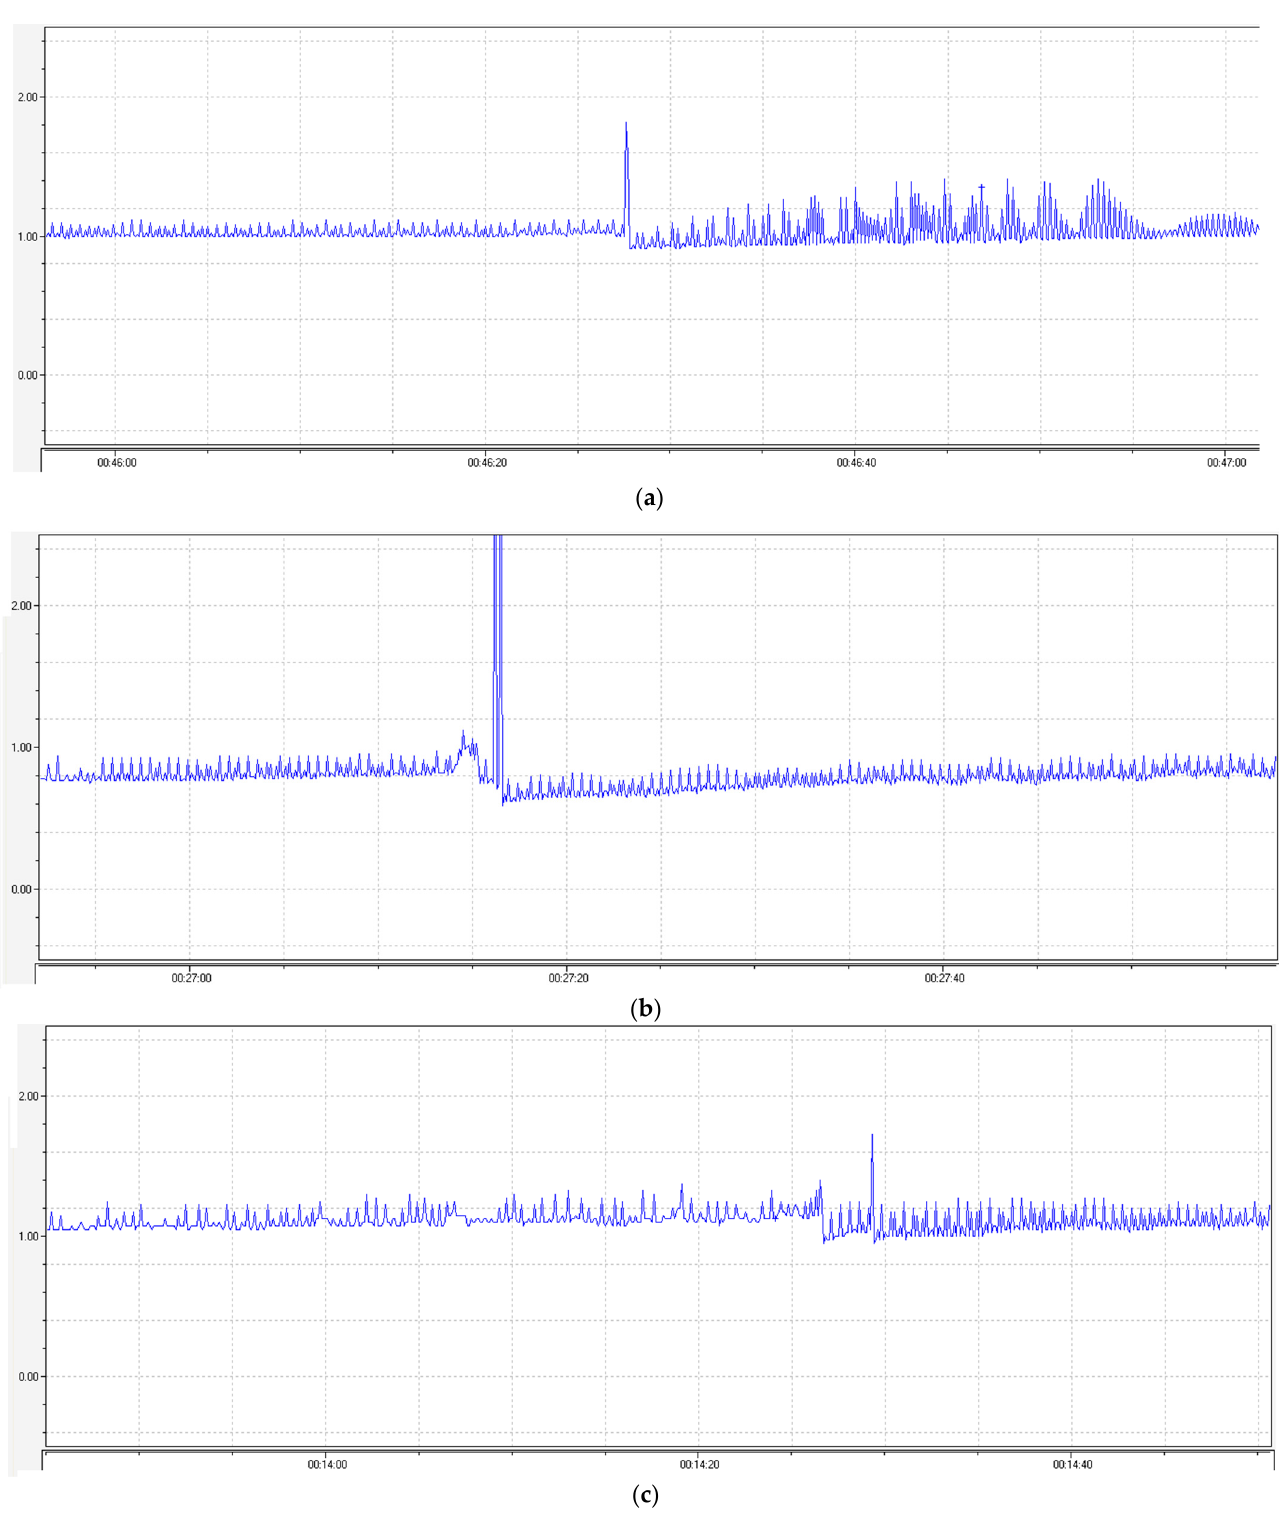
Figure 5. Changes in the atrial contractions of the rat heart when CaCl 2 was injected at a dose of ( a ) 10 − 3 M, ( b ) 10 − 3 M on the background of agent 1 at a concentration of 10 − 4 M, and ( c ) 10 − 3 M on the background of nifedipine at a concentration of 10 − 4 M. The peak shows the injection site of CaCl 2 . No significant changes in the contraction were observed when the test agent 1 was injected into a cuvette with the auricle of heart, but when CaCl 2 was injected, no changes in the atrial contractions typical of the CaCl 2 injection were observed on the background of agent 1 (Figure 5b). The CaCl 2 injection on the background of nifedipine evoked a sig- nificant increase in the contraction amplitude of the rat auricle, as in the case of the agent 1 injection (Figure 5c). The data on the changes in the contraction amplitude and frequency are listed in Table 12. Table 12. Data on changes in contraction amplitude and frequency. Agent/Concentration, (M)